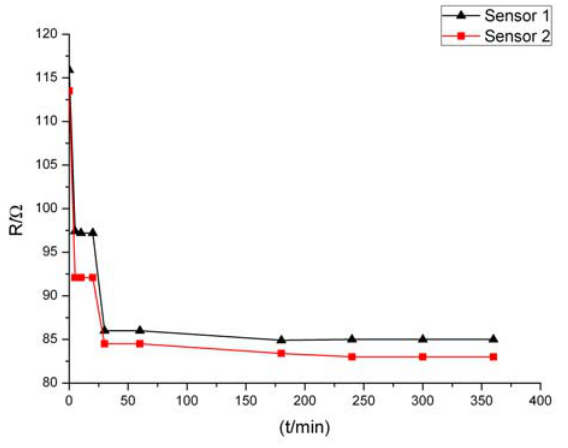
Figure 3. Changes of sensor resistance during electrifying based on self